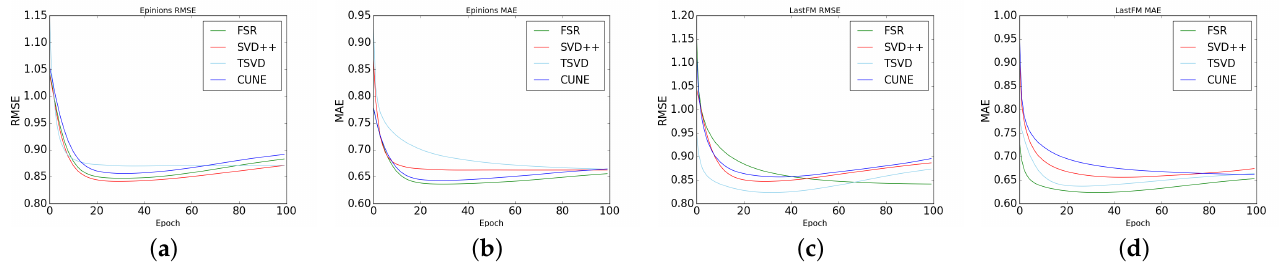
Figure 3. Compared with other baseline models, the FSR model (without introducing side information embedding, but with social influence diffusion layer), the lower the RMSE and MAE, the better the performance. ( a ) Epinions RMSE, ( b ) Epinions MAE, ( c ) LastFM RMSE, ( d ) LastFM